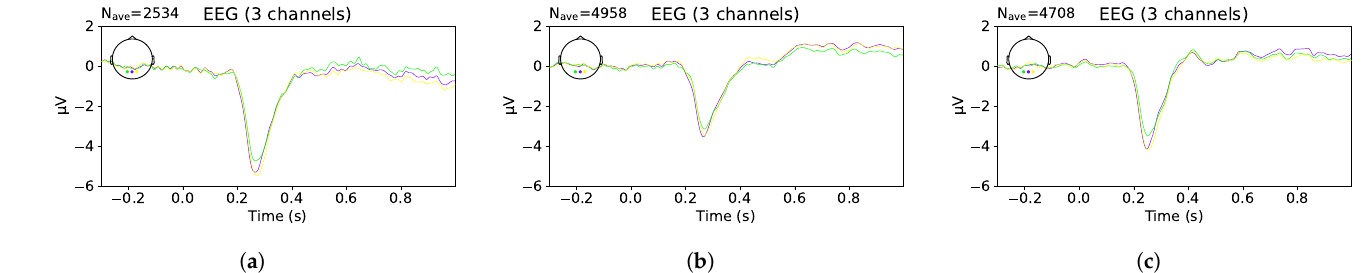
Figure 4. Grand averaged EEG activity for the Oz, O1, and O2 channels at the time of the GO cue during ( a ) executed movement, ( b ) imagined movement, and ( c ) imagined movement with feedback, respectively. N ave denotes the total number of trials that were averaged to obtain the